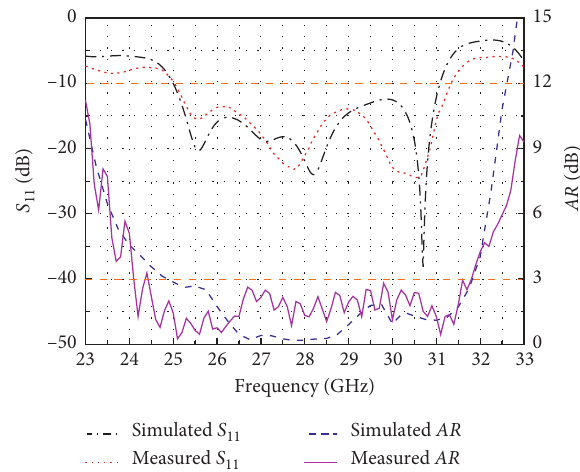
Figure 10: Reflection coefficients and axial ratios of the proposed